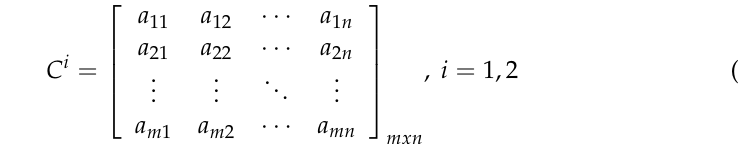
Figure 3. Schematic diagram of regression prediction principle. Let sample space C i be a matrix of m rows and n columns, m is the number of samples and n is the attribute of samples. The first column of the matrix is the regression prediction object, namely demand signal data.